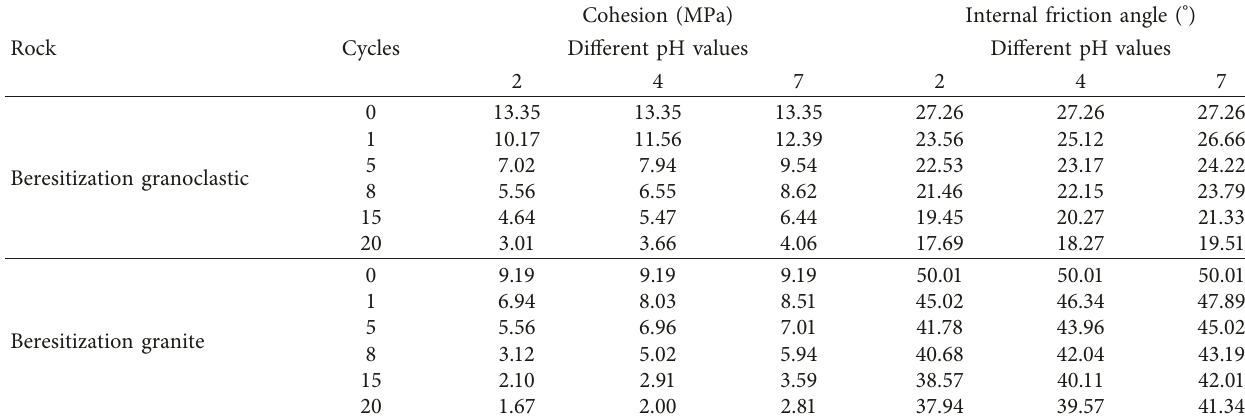
Table 5: Triaxial compression